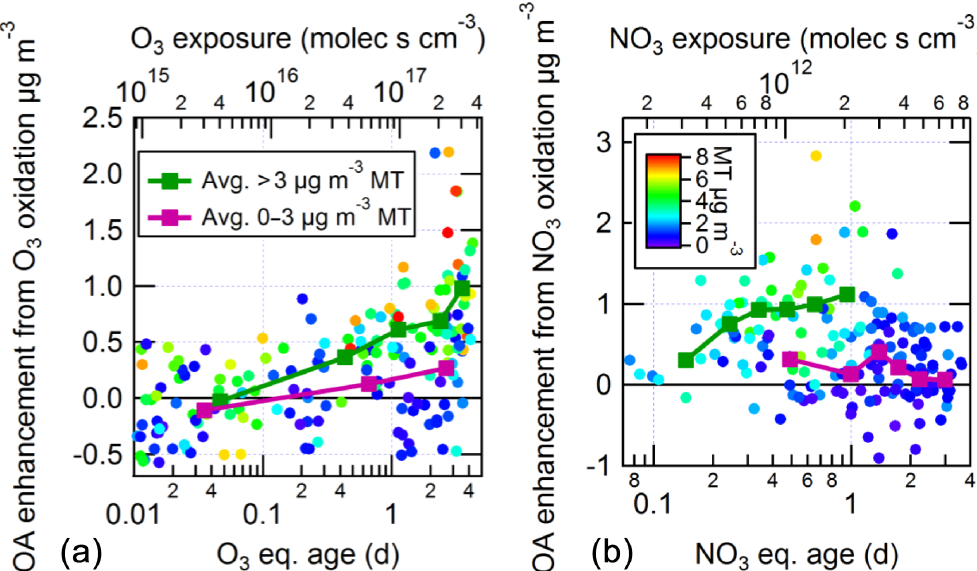
Figure 5. OA enhancement from oxidation of ambient air by O 3 (a) and NO 3 (b) as a function of oxidant exposure. Data are colored by ambient in-canopy MT concentrations and include the LVOC fate correction. Binned averages for times when ambient MT concentrations were either below or above 3µgm − 3 (0.66ppb) are also shown, illustrating the positive relationship between OA enhancement and MT concentrations at the higher oxidant concentrations.